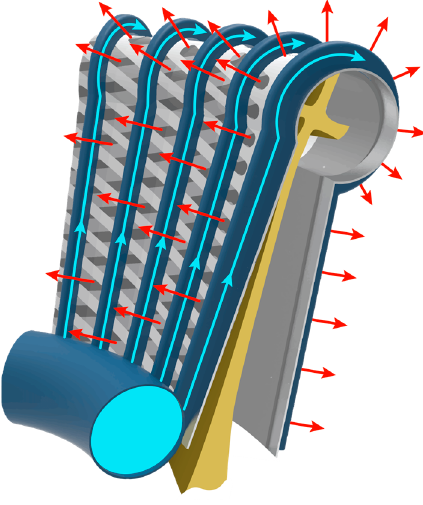
Figure 12. Conceptual design for the PEXS on the divertor leg.